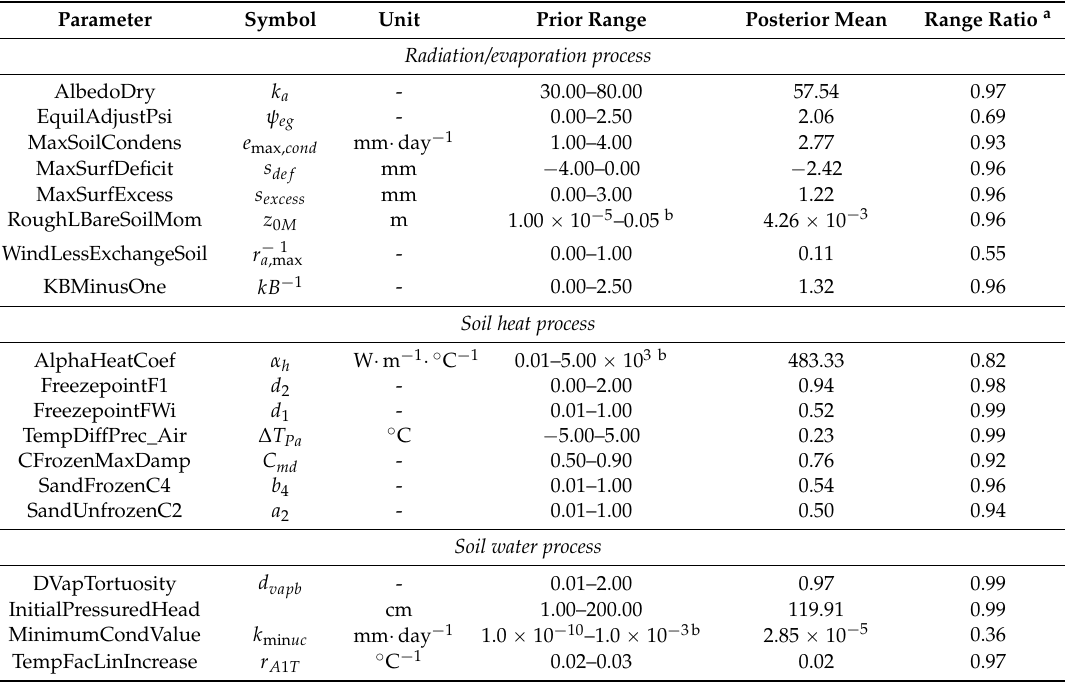
Table 2. Prior and posterior ranges and values for selected parameters. For detailed descriptions of parameters and related equations, refer to Jansson and Karlberg [10].